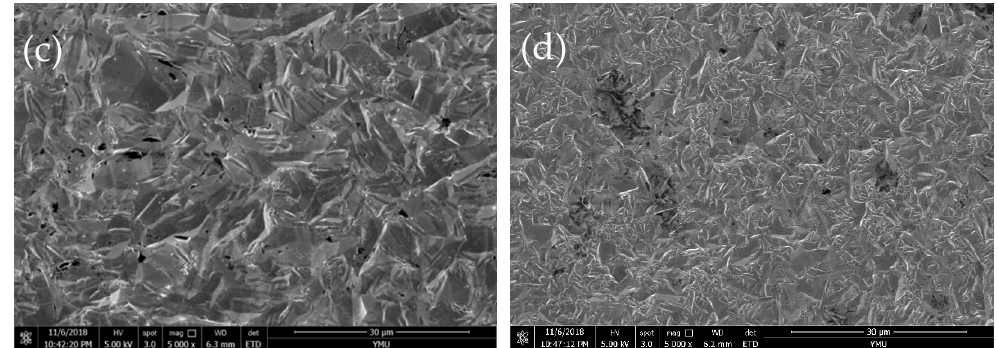
Figure 9. SEM images of Fe–Ni alloys electrodeposited from the chloride baths that contained 0.8 M Ni 2+ ions at ( a ) 50 A·dm − 2 , 30 # , ( b ) 60 A·dm − 2 , 31 # , ( c ) 65 A·dm − 2 , 32 # , and ( d ) 70 A·dm − 2 , 33 # .